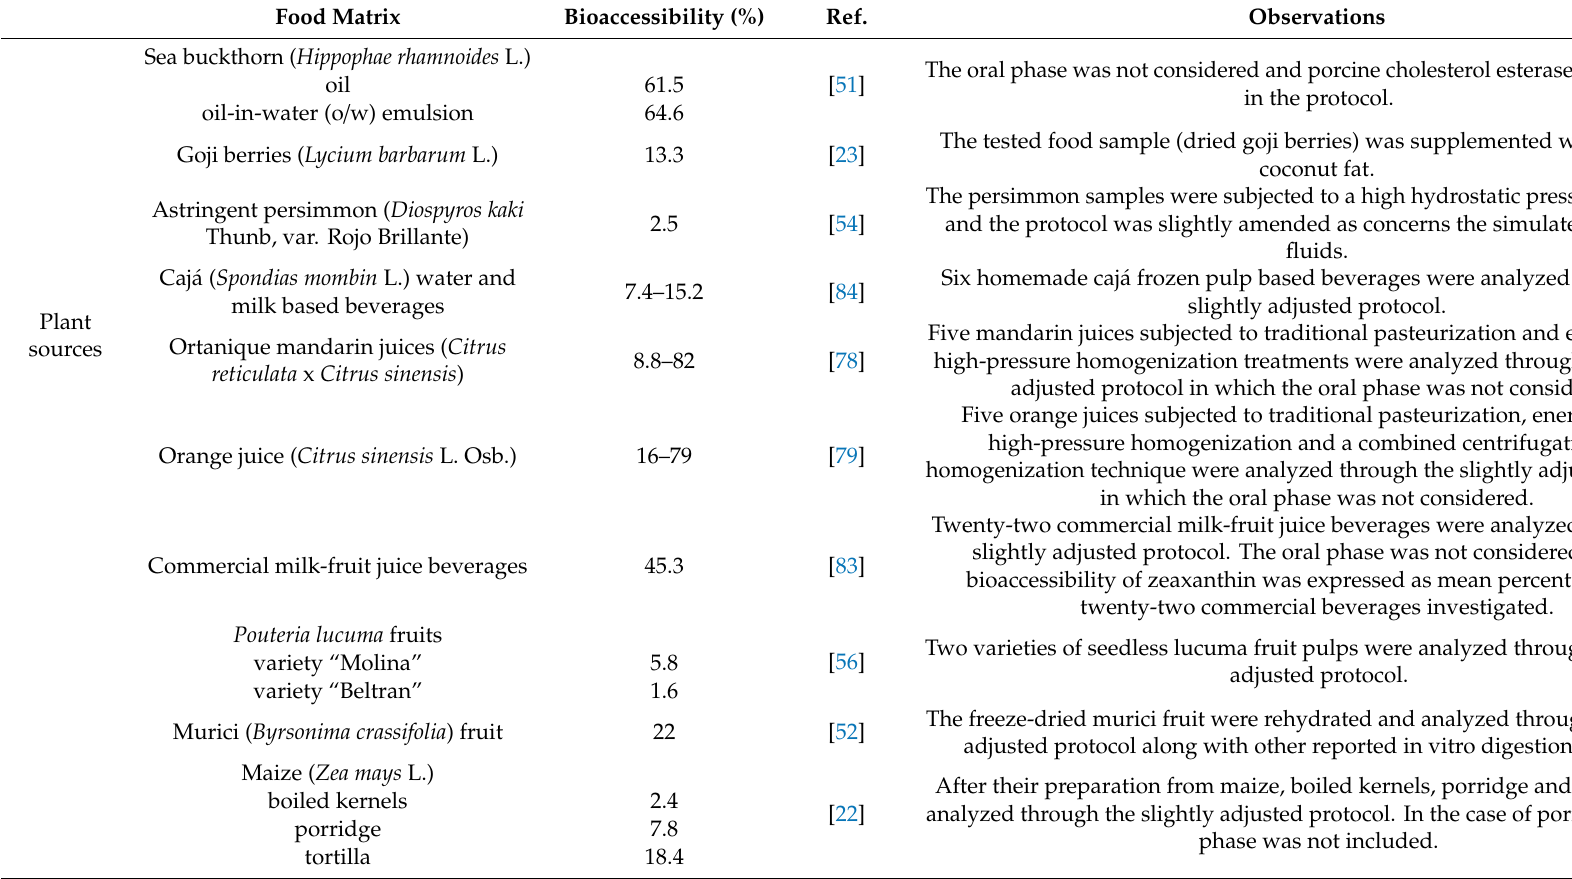
Table 2. Recent research (last 5 years) with regard to zeaxanthin bioaccessibility (%) from di ff erent food sources assessed through the internationally recognized in vitro digestion method